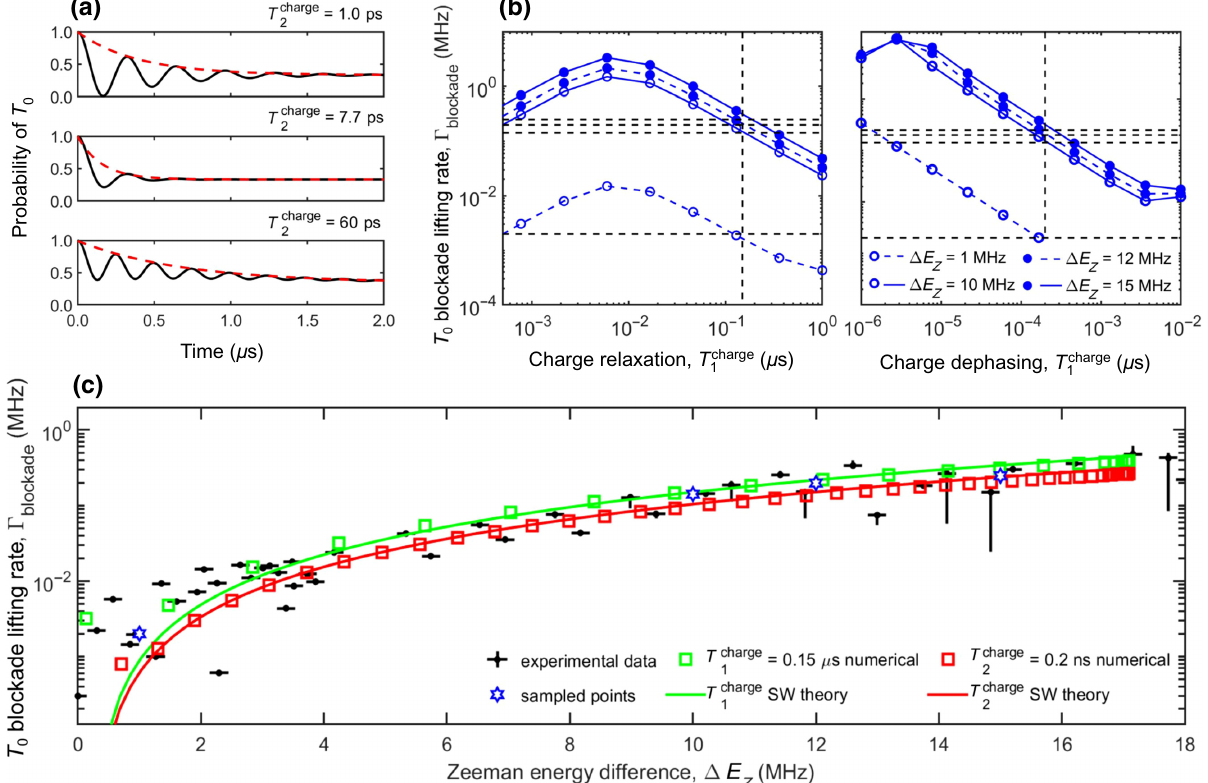
FIG. 3. Numerical model for the blockade lifting. (a) For an initial state | ψ( t = 0 ) (cid:2) = | T 0 ( 1, 1 ) (cid:2) , the probability as a function of time p ( t ) = |(cid:8) T 0 ( 1, 1 ) | ψ( t ) (cid:2)| 2 is calculated numerically using Eqs. (A1), (A2), and (A4), including dephasing processes only. The blockade rate (cid:4) blockade can be extracted from the decay (red dashed line). Comparison between all three plots shows that the decay rate . (b) The extracted decay rates (cid:4) blockade as a function of charge relaxation is not monotonically dependent on the dephasing time T charge 2 and dephasing calculated from the simulation for four values of (cid:3) E Z (blue). The values of (cid:4) blockade that correspond to (cid:3) E Z from the experimental data (black dashed lines) are then used to extract the relaxation and dephasing times. These are T charge = 0.15 μ s. For small values of T charge and T charge , the blockade lifting is halted [37]. (c) The comparison of (cid:4) blockade and (cid:3) E Z for T charge 1 2 1 the experiment (black dots) against the numerical (squares) and analytical (solid line) theoretical decay processes adopting T charge = 0.15 μ s (green). The blue stars indicate the sampled points used to match the relaxation and dephasing times ns (red) or T charge 1 in